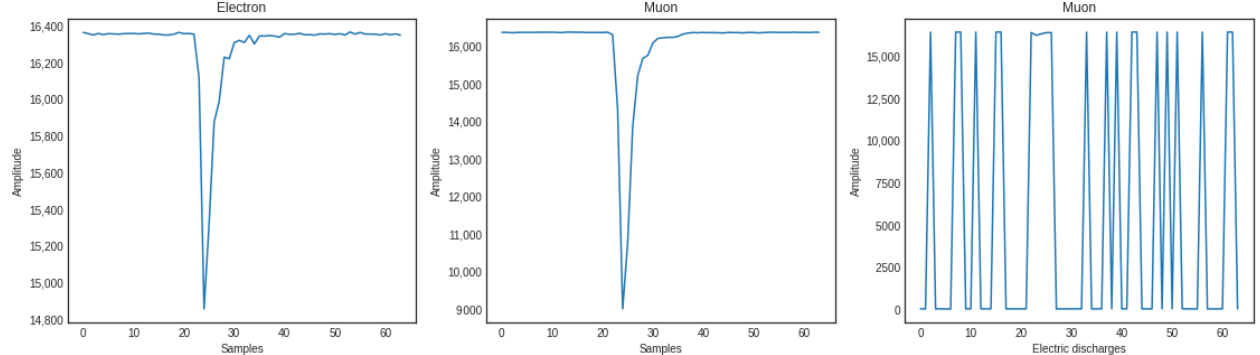
Figure 5. Different types of signals: electron, muon and electric discharges.